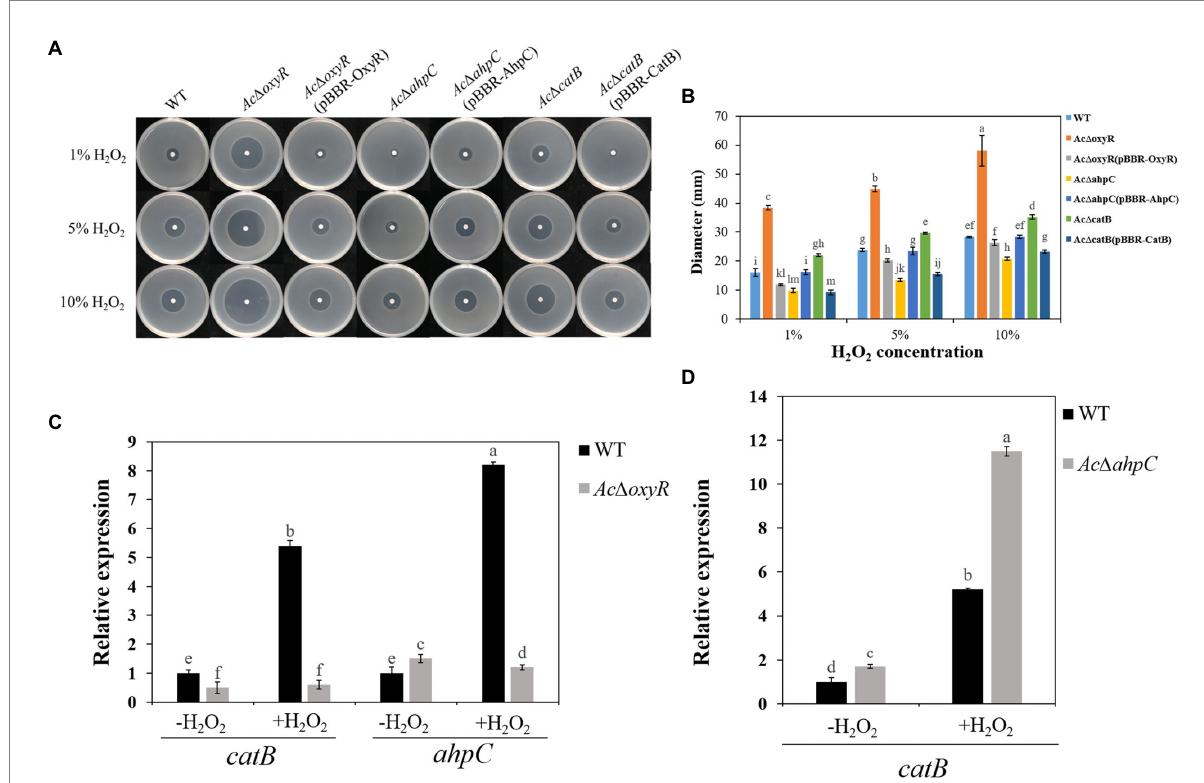
FIGURE 2 Sensitivity of WT, Ac Δ oxyR , Ac Δ oxyR (pBBR-OxyR), Ac Δ ahpC , Ac Δ ahpC (pBBR-AhpC), Ac Δ catB , Ac Δ catB (pBBR-CatB), and WT(pBBR-CatB) strains to H 2 O 2 . (A) Three microliters of different concentrations (1, 5, and 10%) of H 2 O 2 were dropped in the center of the plates. The H 2 O 2 inhibition zones were observed and measured after incubation at 28 ° C for 24 h. (B) The diameter of the zone of bacterial growth inhibition. (C) Expression of catB and ahpC in A. citrulli WT and Ac Δ oxyR grown in LB medium with or without 1 mm H 2 O 2 and determined by qRT-PCR. (D) Expression of catB in A. citrulli WT and Ac Δ ahpC grown in LB medium with or without 1 mm H 2 O 2 and determined by qRT-PCR. Experiments were performed in triplicate and were repeated three times with similar results. Data represent the means of three replicates ± standard deviations (error bars). Different lowercase letters indicate a significant difference between treatments. Statistically significant differences were determined by the one-way ANOVA of variance and p <